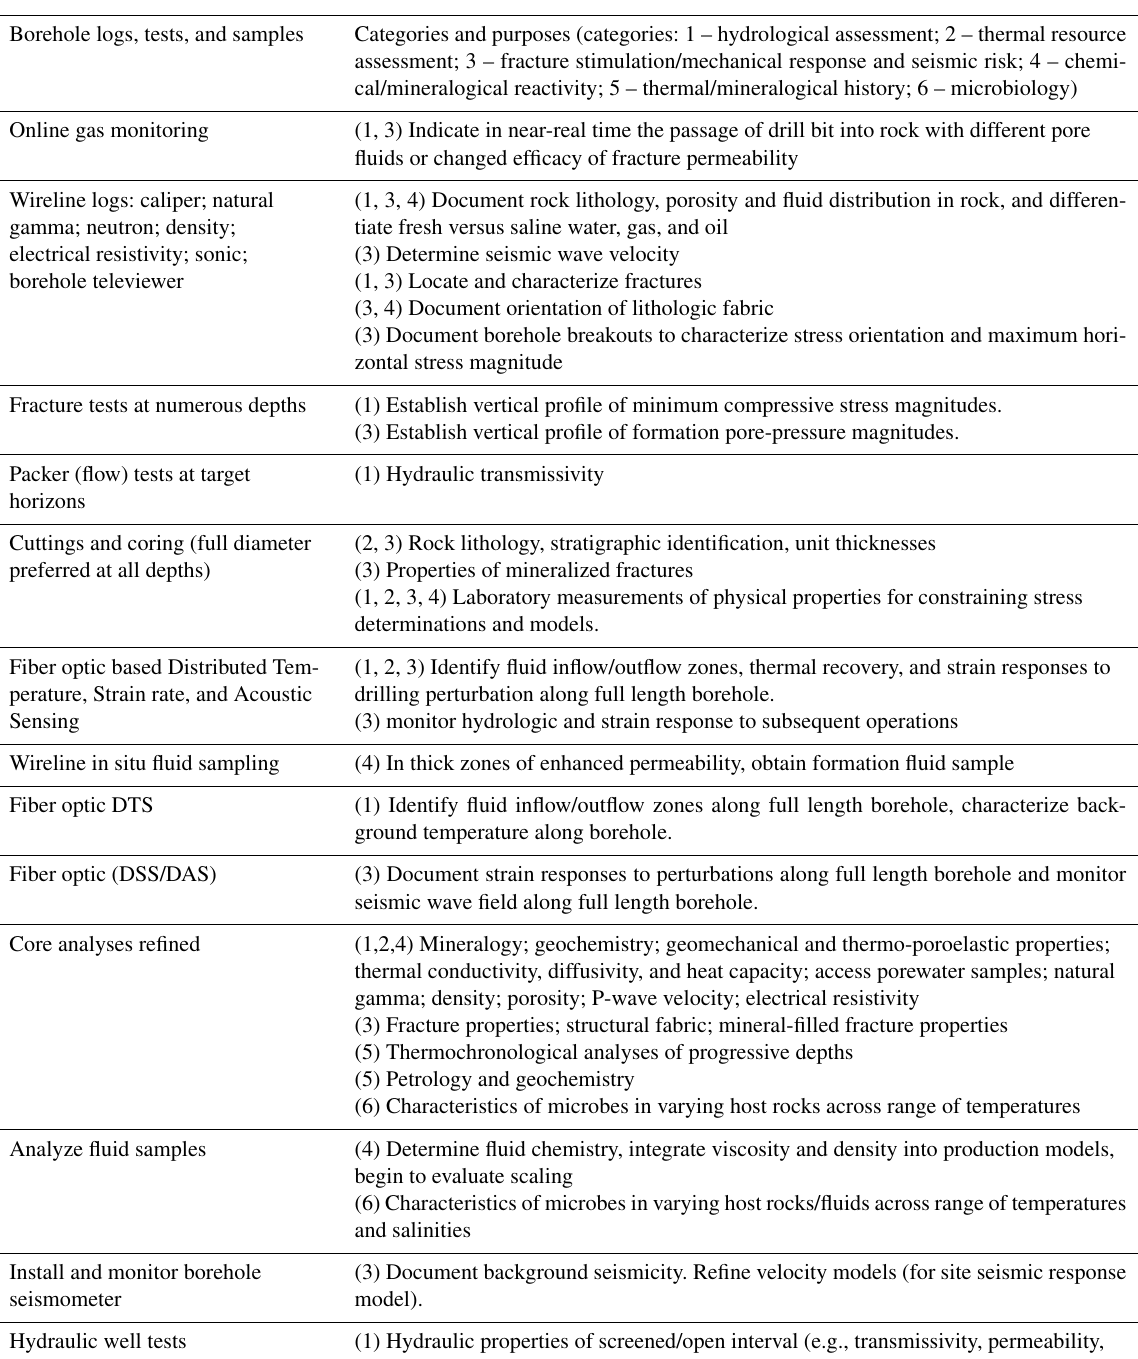
Table 1. Initial borehole logs, tests and samples recommended for Hole 1A and their purposes. Borehole logs, tests, and samples Categories and purposes (categories: 1 – hydrological assessment; 2 – thermal resource assessment; 3 – fracture stimulation/mechanical response and seismic risk; 4 – chemi- cal/mineralogical reactivity; 5 – thermal/mineralogical history; 6 –